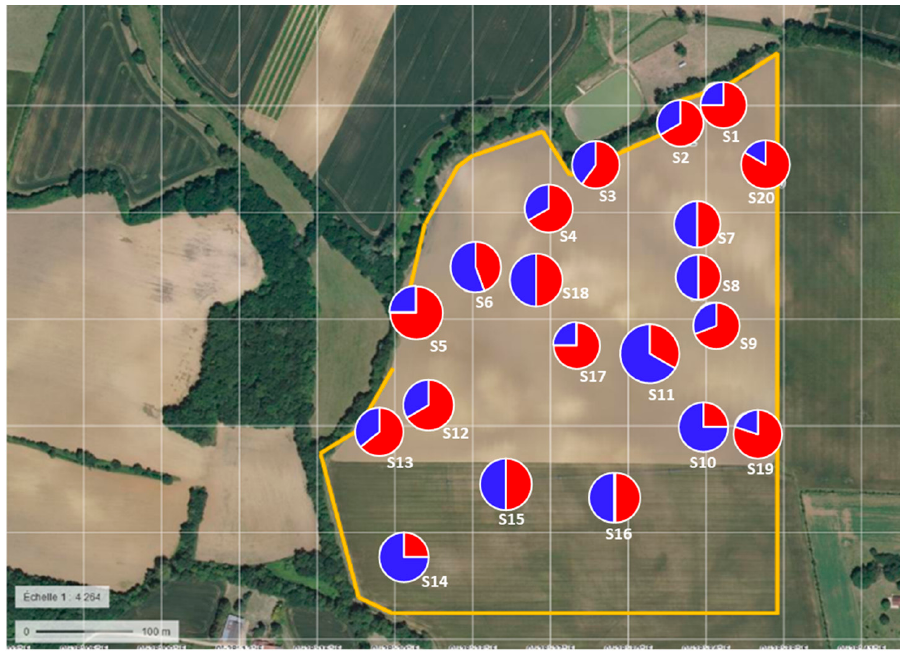
Figure 4. P. halstedii genotypes plotted in the field following their cluster assignment (C1 = red; C2 = blue) on the 20 sampling sites S1 to S20 (satellite image from https://www.geoportail.gouv.fr accessed on 5 September 2022).